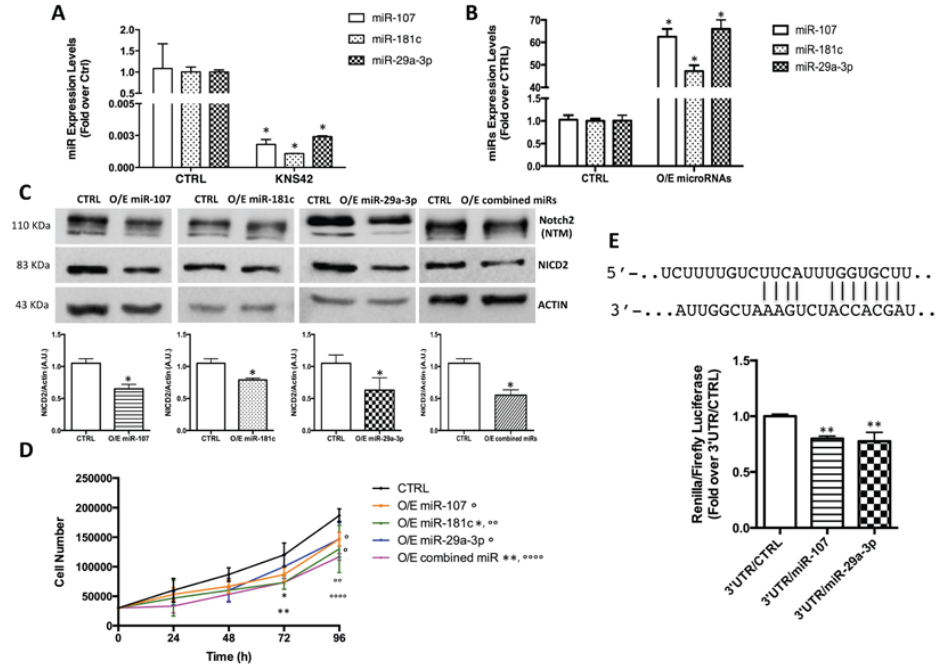
Figure 3. miR-107, miR-181c and miR-29a-3p inhibit pHGG cell proliferation by targeting Notch2. ( A ) Single assay qPCR validation of miR-107, miR-181c, and miR-29a-3p expression in KNS42 cells versus non-neoplastic total brain (CTRL). * p < 0.05 vs. CTRL; ( B , C ) KNS42 cells were transfected